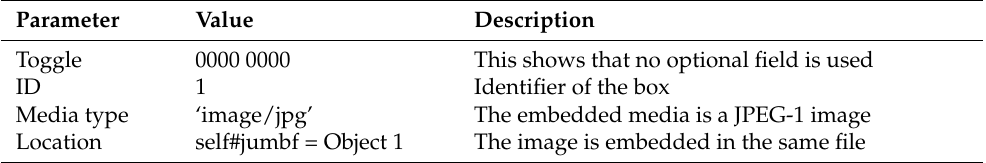
Table A14. Values of the first OBMB parameters for the fourth example.